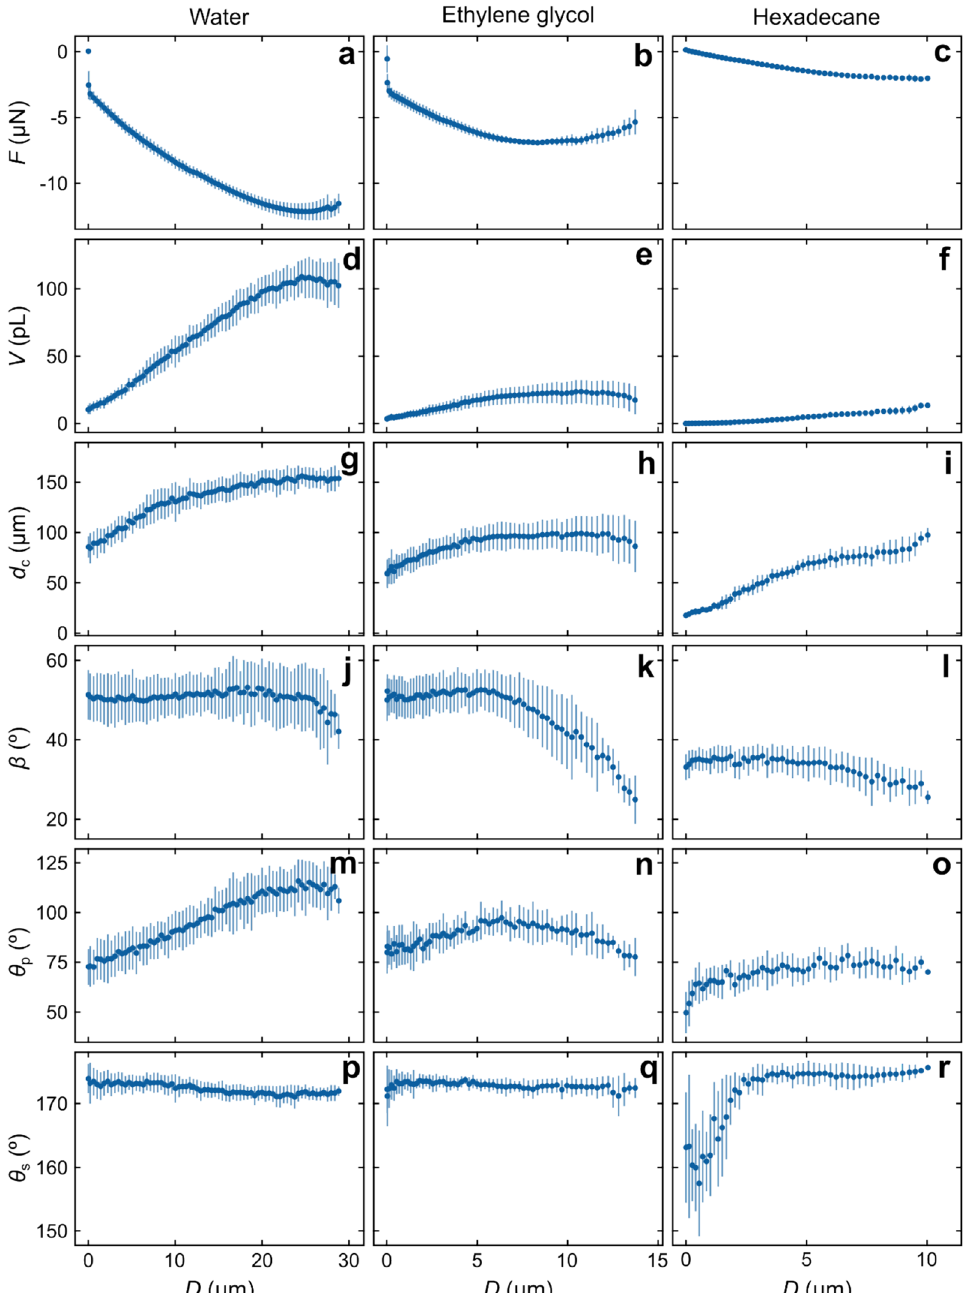
Figure 5. Diagrams of ( a – c ) force F , ( d – f ) capillary volume V , ( g – i ) diameter of the de-wetted area on the superamphiphobic surface d c , ( j – l ) angle β defining the de-wetted area on the particle and microscopic contact angles at the gas–liquid interface of the particle θ p ( m – o ), and on the superamphiphobic surface θ s ( p – r ) as a function of separation D for measurements in water, ethylene glycol and hexadecane. Error bars show the standard deviations. The piezo expansion rate was 0.2 µm s −1